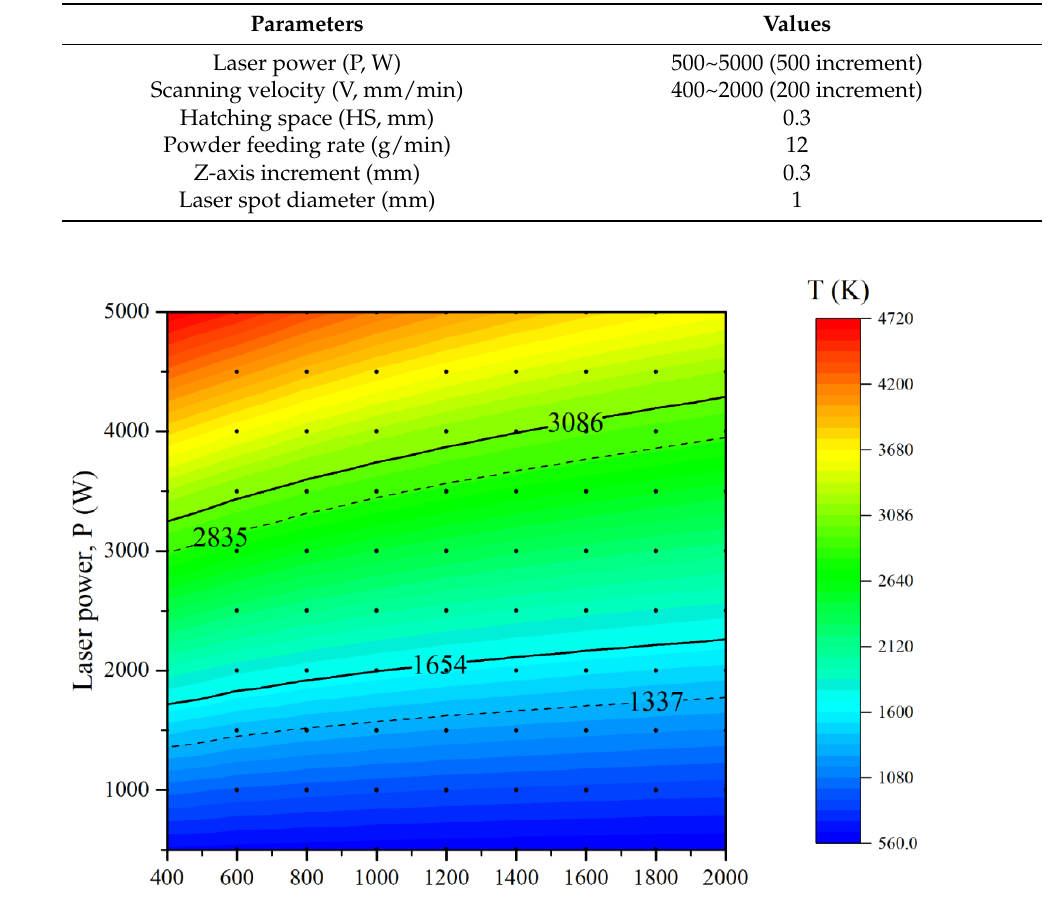
Table 2. Processing parameters for the first layer.